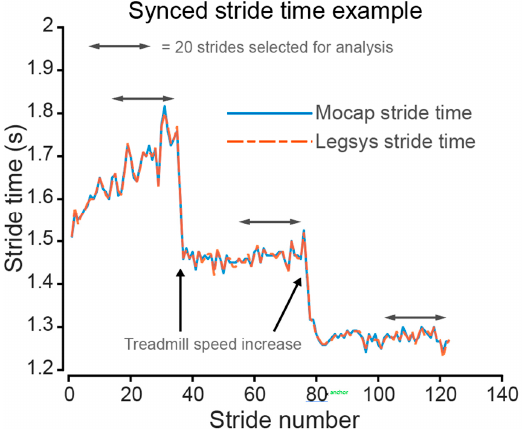
Figure 4. Synchronisation example between the LEGSYS+ and MOCAP for stride time. Plot of stride time against stride number for LEGSYS+ (blue line) and MOCAP (orange dotted line) for a single individual. The single head arrows show treadmill speed changes (2, 3, 4 km/h). The twenty strides prior to treadmill speed change (doubled head arrow) were selected for comparison.